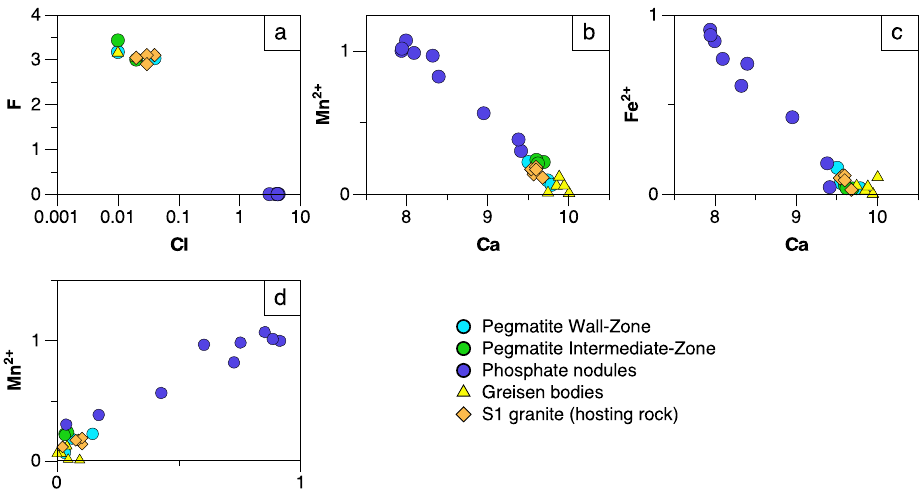
Figure 5. Binary plots for apatite from the different units of the Puentemocha P-rich pegmatite (all the values in a.p.f.u): ( a ) Cl versus F; ( b ) Ca versus Mn; ( c ) Ca versus Fe; and ( d ) Fe versus Mn.